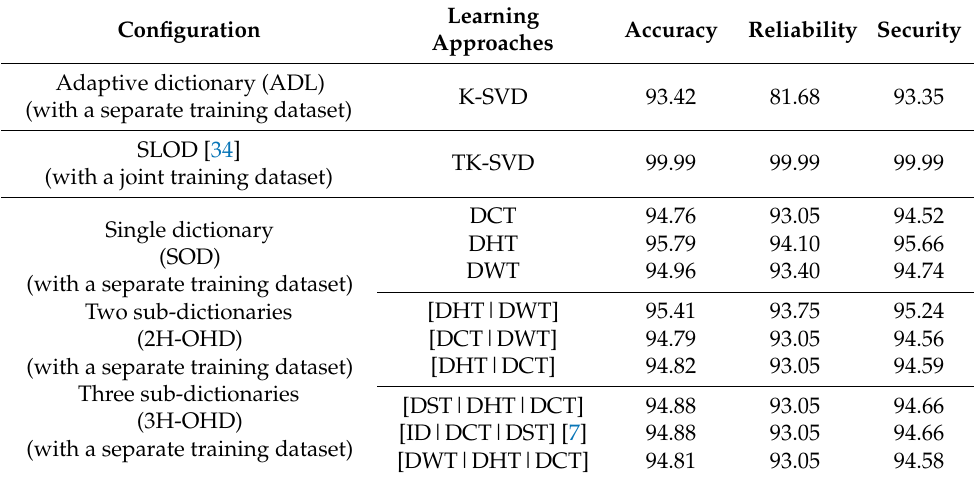
Table 4 that all fixed dictionaries provided a decent performance with right to all metrics using separate stable/unstable datasets in contrast to K-SVD dictionary whose reliability is pretty-weak. Table 4. TSA metric comparisons of fixed and adaptive supervised dictionary learning.